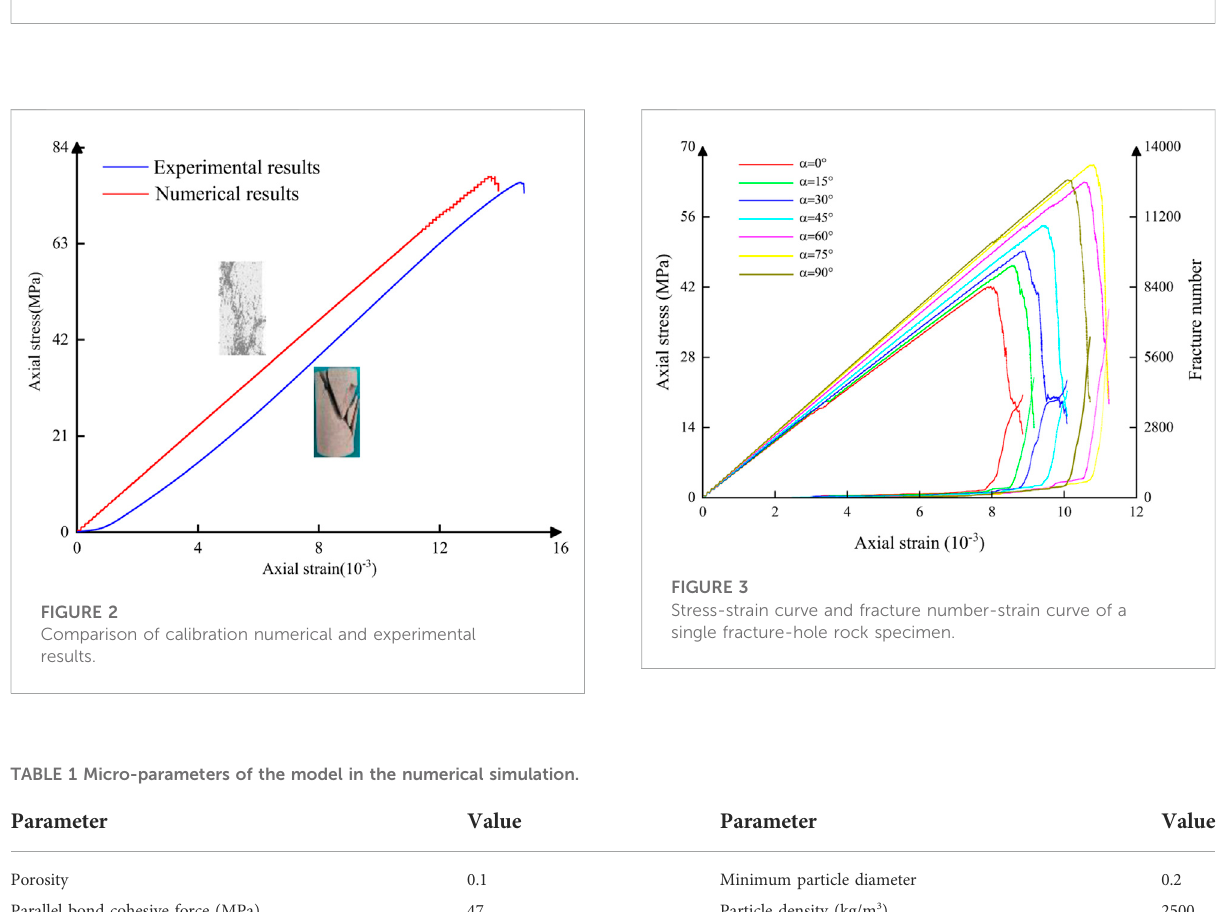
FIGURE 1 Parallel bond model (Cundall and Strack, 1979).